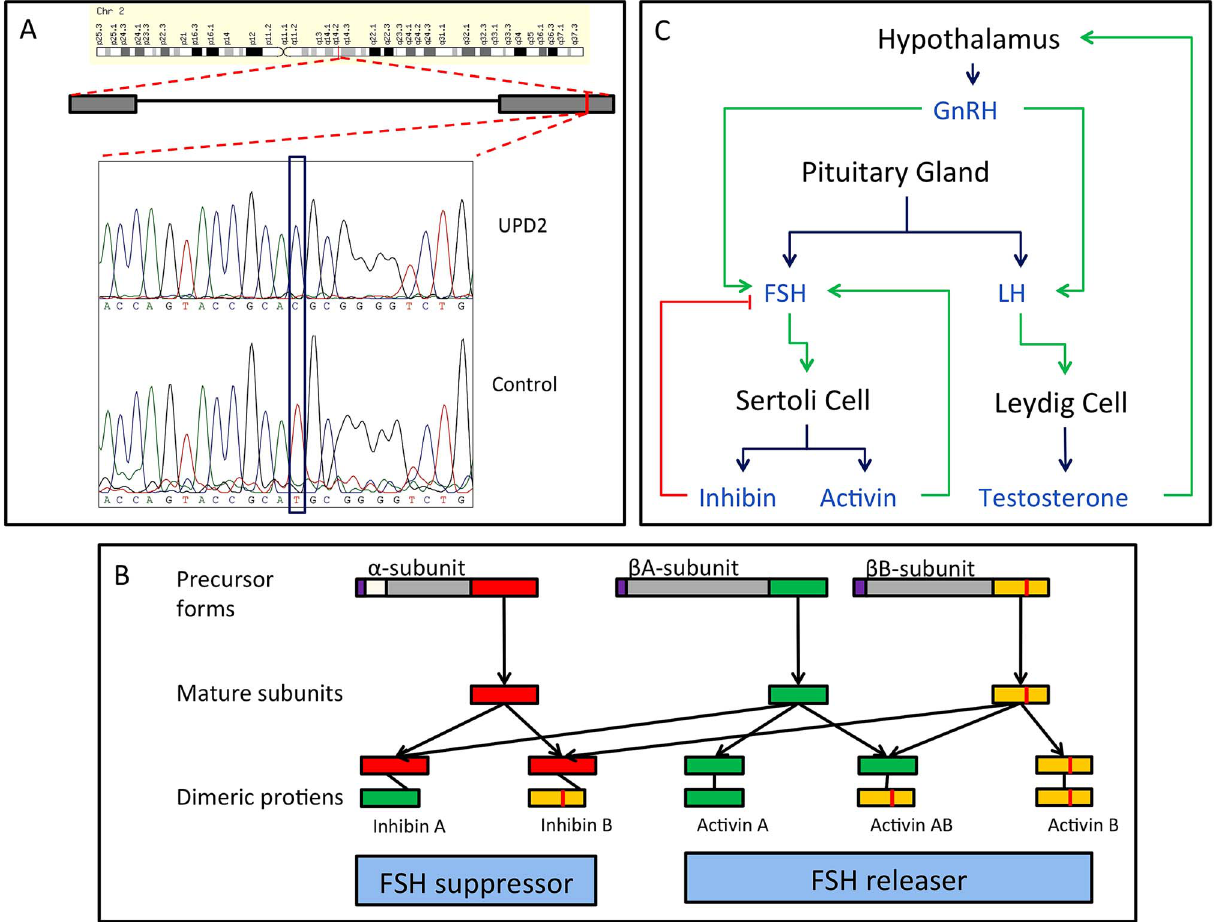
Figure 6. Homozygous missense mutation of INHBB identified in the case of UPD2. (A) We validated this candidate by Sanger sequencing in the UPD2 case and control individuals. Mutant and reference nucleotides are highlighted within the blue box, confirming the homozygous T to C nucleotide change observed at chr2:12,1107,305 bp (hg19) of the UPD2 individual. Grey boxes represent the exons of the gene and the red line indicates the location of the observed mutation within the gene. (B) INHBB encodes for the protein, Inhibin b B, which along with inhibin a and inhibin b A, combine combinatorially to form the inhibins and activins. Each protein expressed by INHA , INHBA , INHBB consists of an N-terminal signal peptide (purple), a propeptide (grey), and a subunit chain (green, red or yellow). The mutation identified here results in a M370T change of the inhibin b B subunit chain (location indicated by a vertical red line throughout the diagram). The various inhibin subunits dimerize via disulfide bonds (locations indicated by black lines between subunits). As the b B subunit participates in multiple complexes with antagonistic functions, the functional consequences of loss-of-function or gain-of-function mutations in this protein may be difficult to predict. (C) The role of inhibins and activins in the hypothalamic-pituitary testicular axis. These complexes have diverse functions in the body, but are most well known for their ability to stimulate and inhibit follicle stimulating hormone (FSH) production, a process critical for spermatogenesis. Blue arrows connect hormones to the cell or gland by which they are secreted. Green arrows indicate stimulatory interactions, and red lines indicate inhibitory interactions.